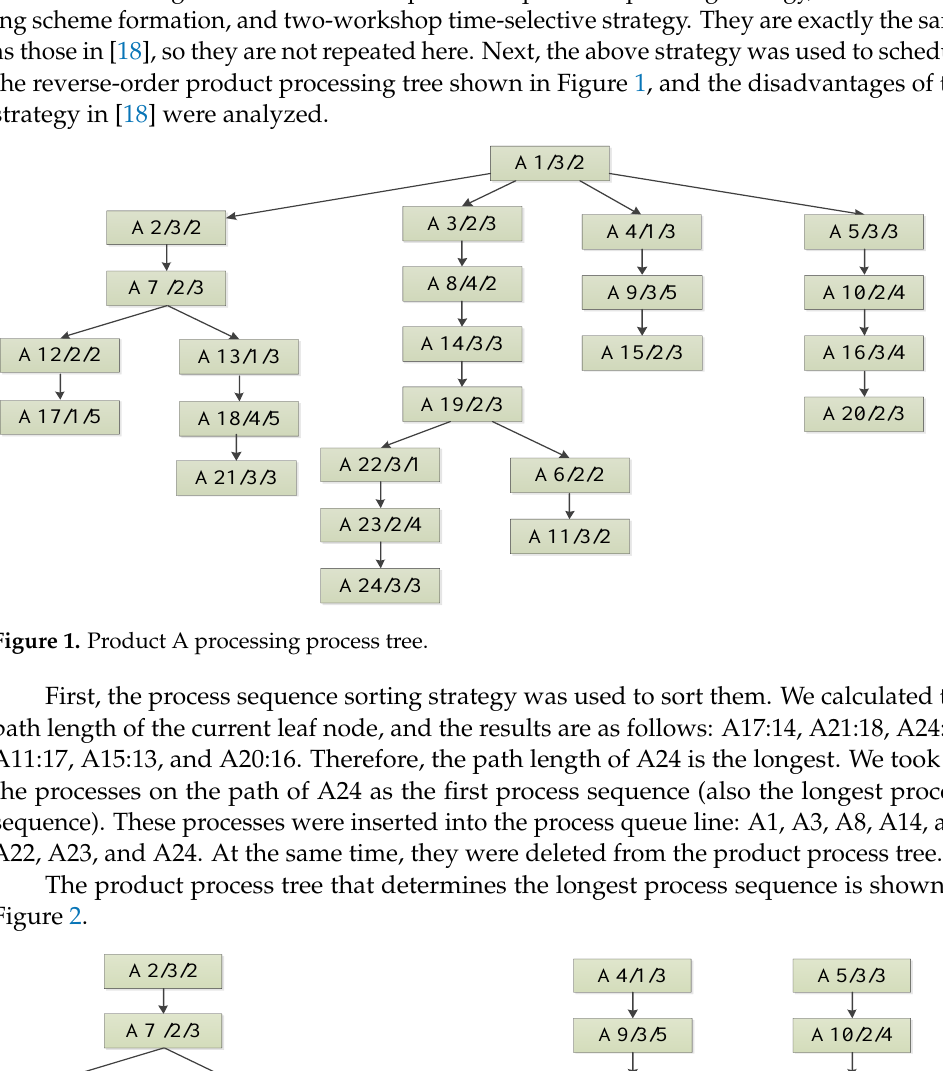
Figure 2. The product process tree becomes a forest when the first process sequence is determined.